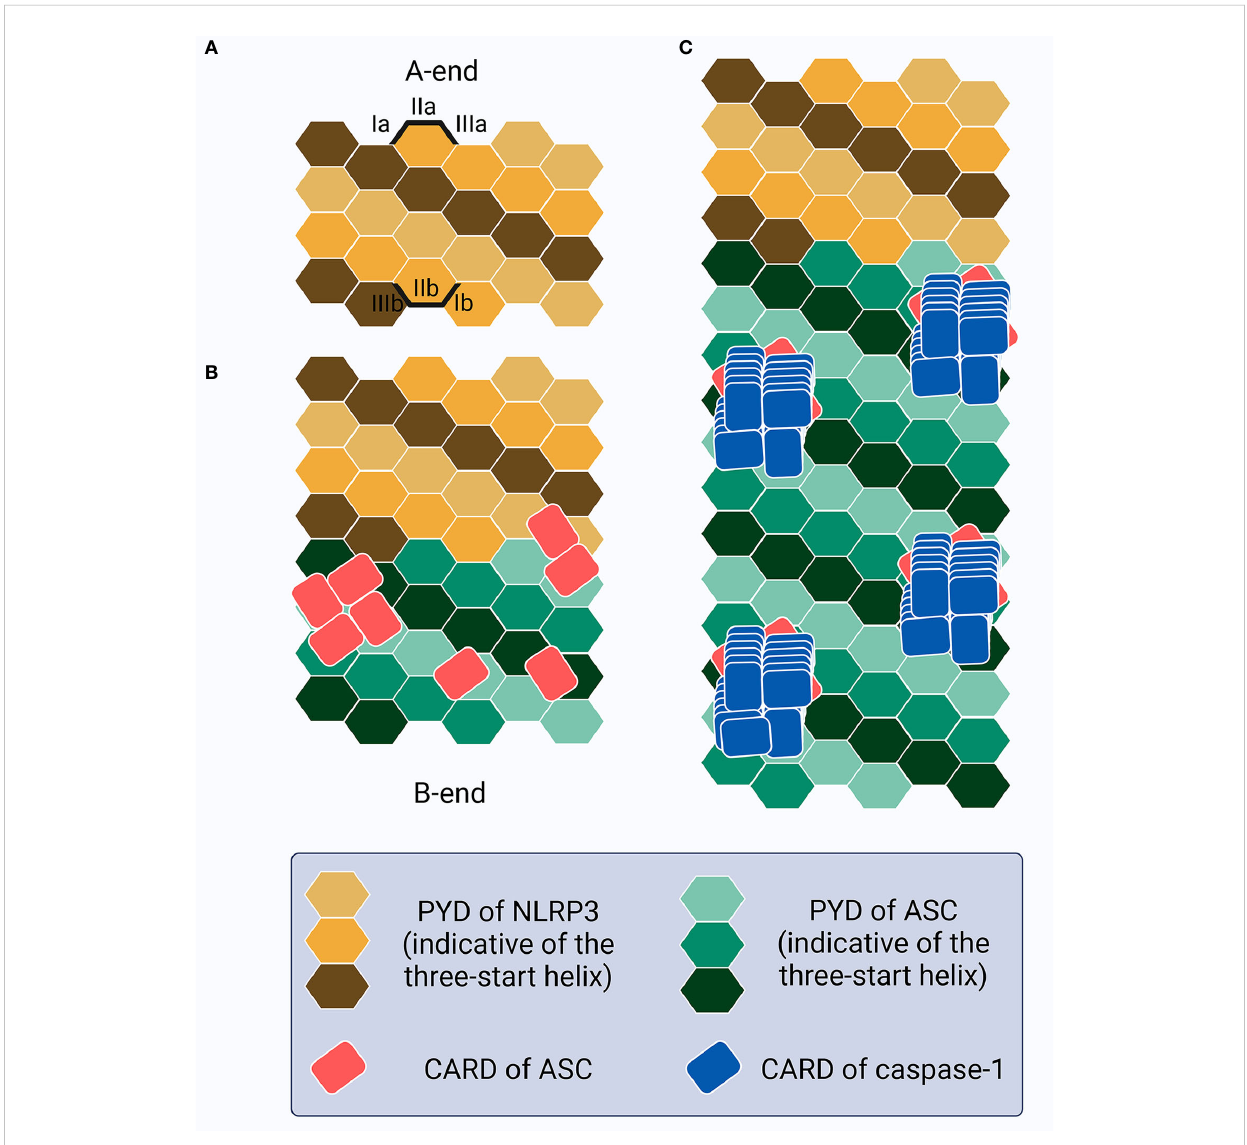
FIGURE 3 Schematic of the ASC speck formation. (A) The PYDs in sensors (e.g., NLRP3) oligomerize as a seed to recruit the PYDs of ASC. (B) This homotypic PYD-PYD interaction creates a unidirectional (A-end to B-end), right-handed, three-start helix as a linear ASC fi lamentous backbone structure with CARDs exposed and self-interacting outside the fi laments, resembling buds on the stem surface. (C) CARD-CARD interaction between ASC and caspase-1 allows caspase-1 recruitment as a left-handed one-start helix, thus increasing the local concentration and promoting